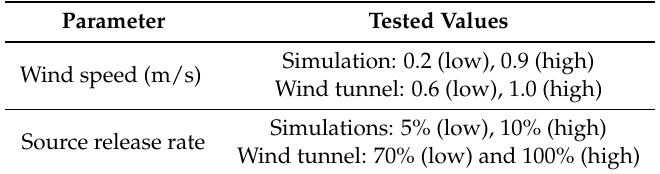
Table 2. Environmental parameters studied in simulations and wind tunnel experiments.